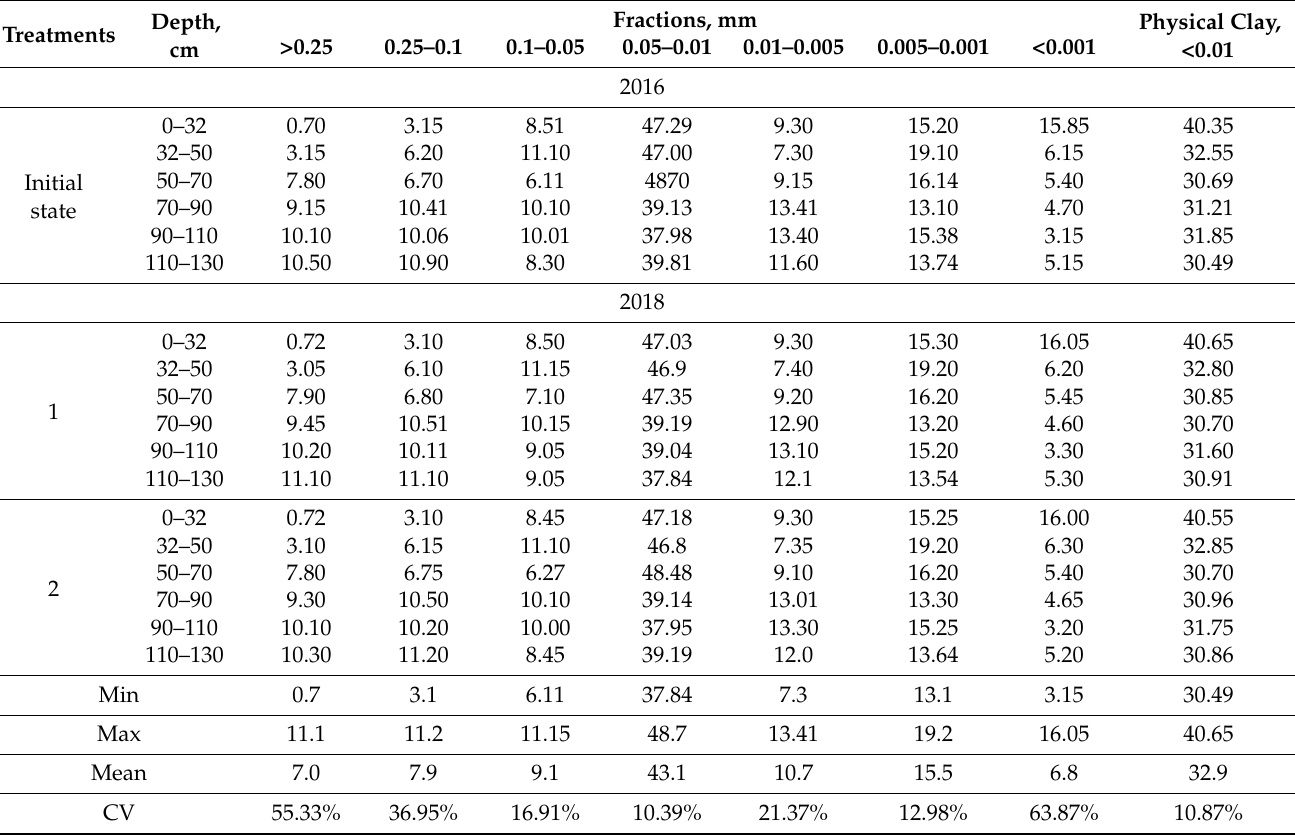
Table 2. Particle size distribution of the